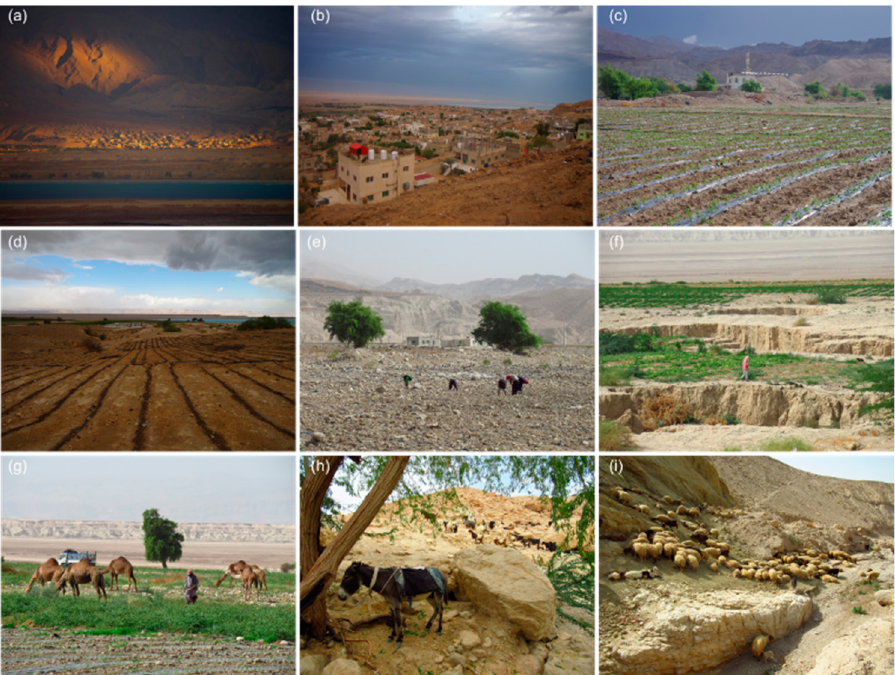
Figure 4. The communities and their activity inside the proposed geopark highlight area of Ghor Al ‐ Haditha. ( a , b ) View of Ghor Al ‐ Haditha town. ( c – f ) agricultural farming areas that are subject to dangerous sinkhole collapse. ( g – i ) sheep, goat, and camel farming are traditional sources of income. Photos were taken by D. Al ‐ Halbouni.